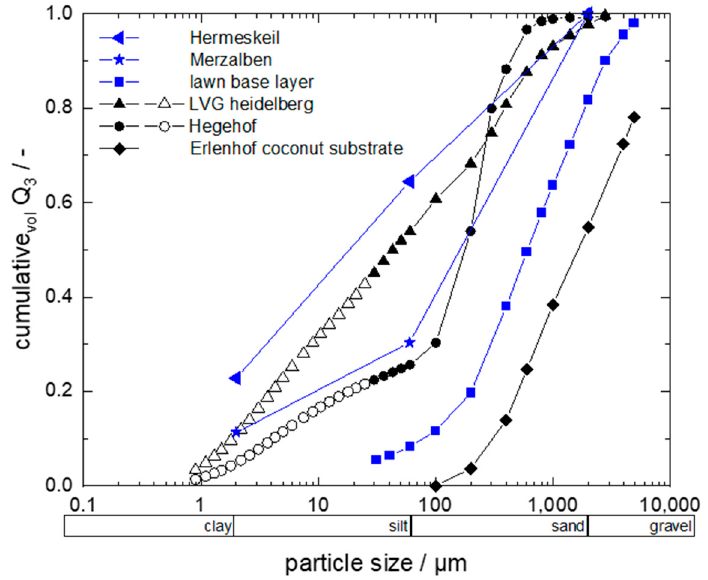
Figure 1. Particle size analysis of the used soils. Cumulative distribution Q 3 was determined through sieve analysis (open symbols) and through Fraunhofer diffraction (filled symbols).